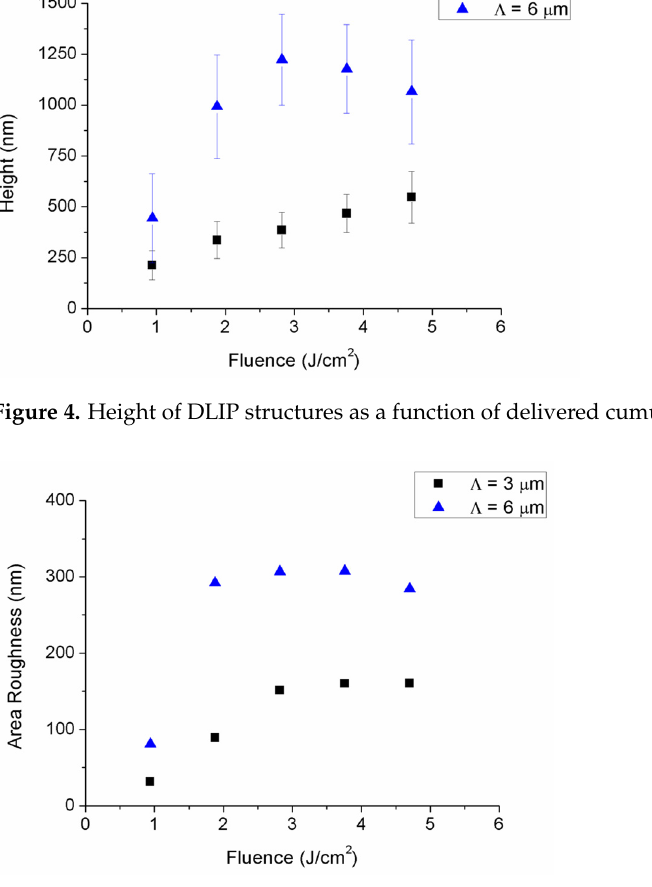
Figure 5. Surface roughness of structured samples as a function of delivered fluence.